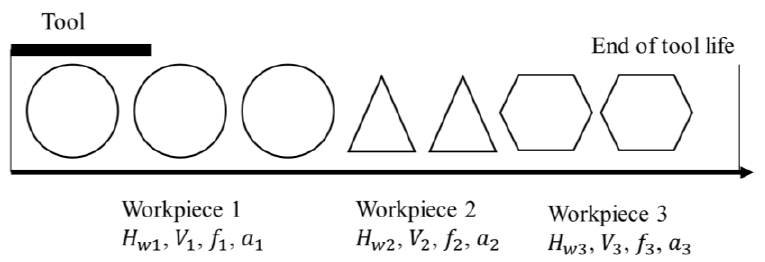
Figure 13. Manufacturing in small-lot production with a tool.